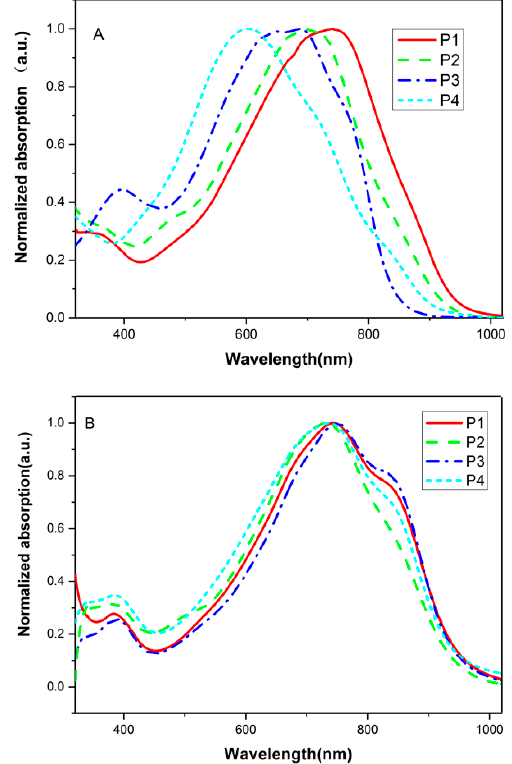
Figure 2. UV-vis spectra of P1, P2, P3 and P4 in dilute chloroform solutions (10 − 6 mol/L) ( A ) and films (spin coating from chloroform solutions) ( B ). Table 1. The UV-vis spectra data and energy levels of four polymers.